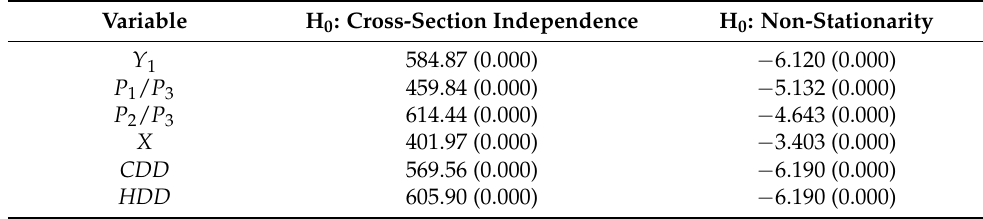
Table 3. Test statistics for cross-section independence and non-stationarity; p -values in ( ).